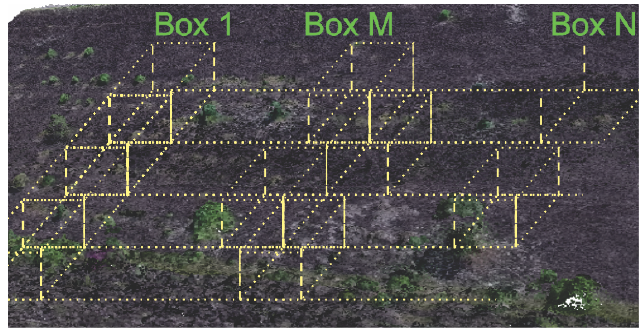
Figure 3. Boxing